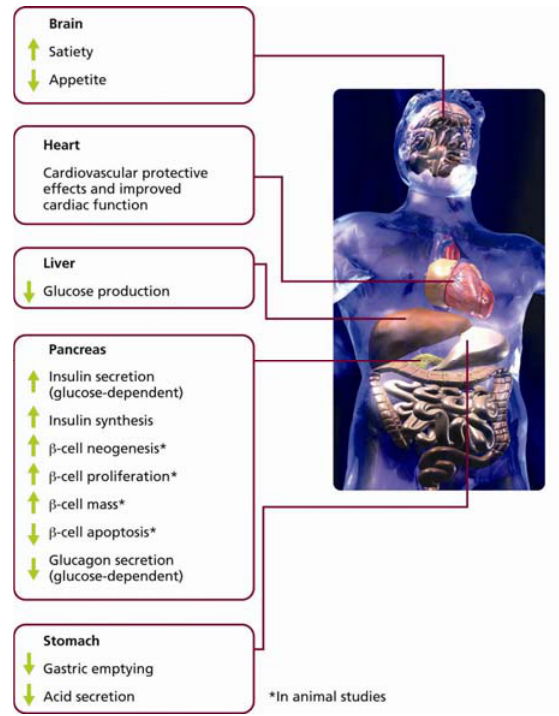
Figure 4. Physiological Pathways of